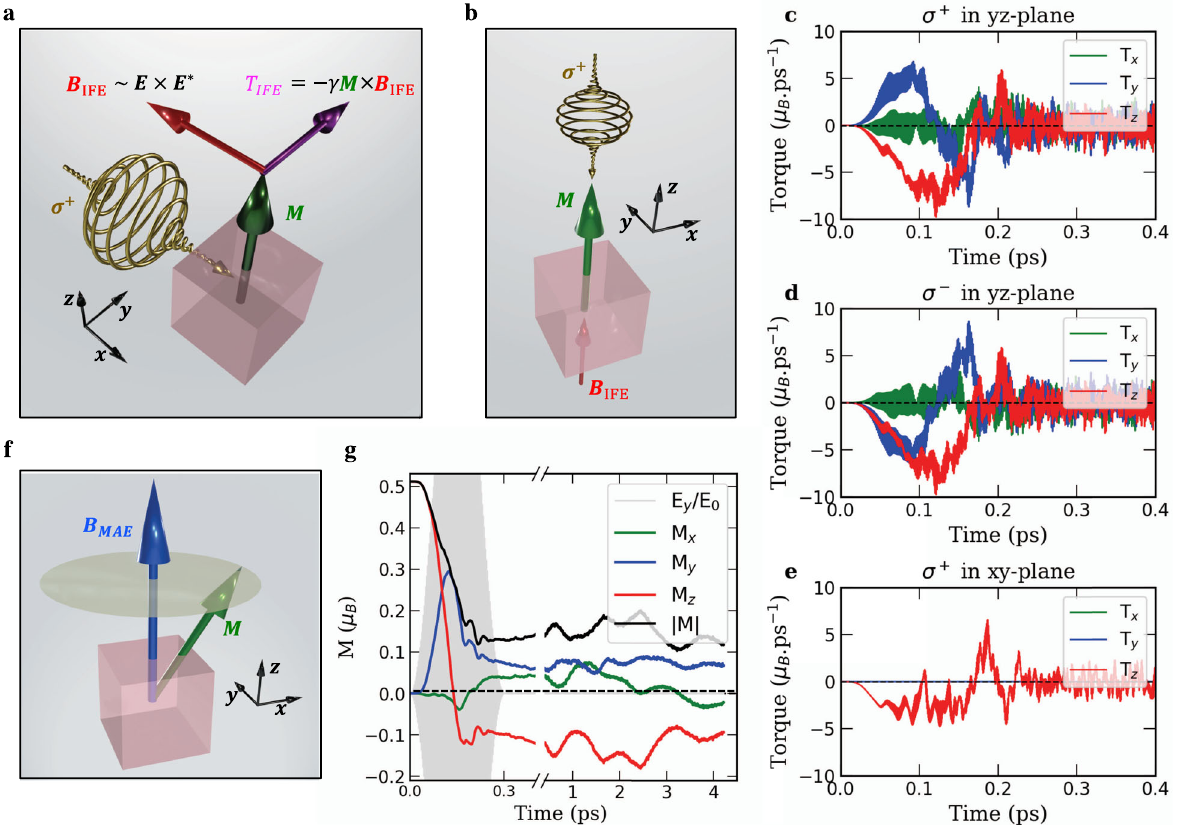
Fig. 4 Laser-induced ultrafast magnetic torques on bulk Ni. a , b Schematic illustrations representing a laser acting on an initial magnetization along the z -axis: ( a ) a right-circularly polarized pulse ( σ + ) in the yz -plane induces an inverse Faraday-like magnetic fi eld ( B IFE ) opposite to the polarisation direction ( − x ), which at t = 0 exerts a torque ( T IFE ) on the magnetization ( M ) along the + y direction; ( b ) a right-circularly polarized pulse in the xy -plane would generate an inverse Faraday-like magnetic fi eld parallel to the magnetization ( + z ) and so at t = 0 it exerts no torque. c – e The components of the torques induced by a 300 fs wide pulse with the intensity of E 0 = 9.7 × 10 9 V m − 1 that is c right-circularly polarized in the yz -plane, d left-circularly polarized ( σ − ) in the yz -plane, and e right-circularly polarized in the xy -plane, respectively, computed according to Eq. (1). f The magnetization dynamics also have a contribution from the internal fi eld due to the magnetic anisotropy (MAE) which induces precession. g The three components of magnetization ( M ) along with the total length correspond to the case shown in ( c